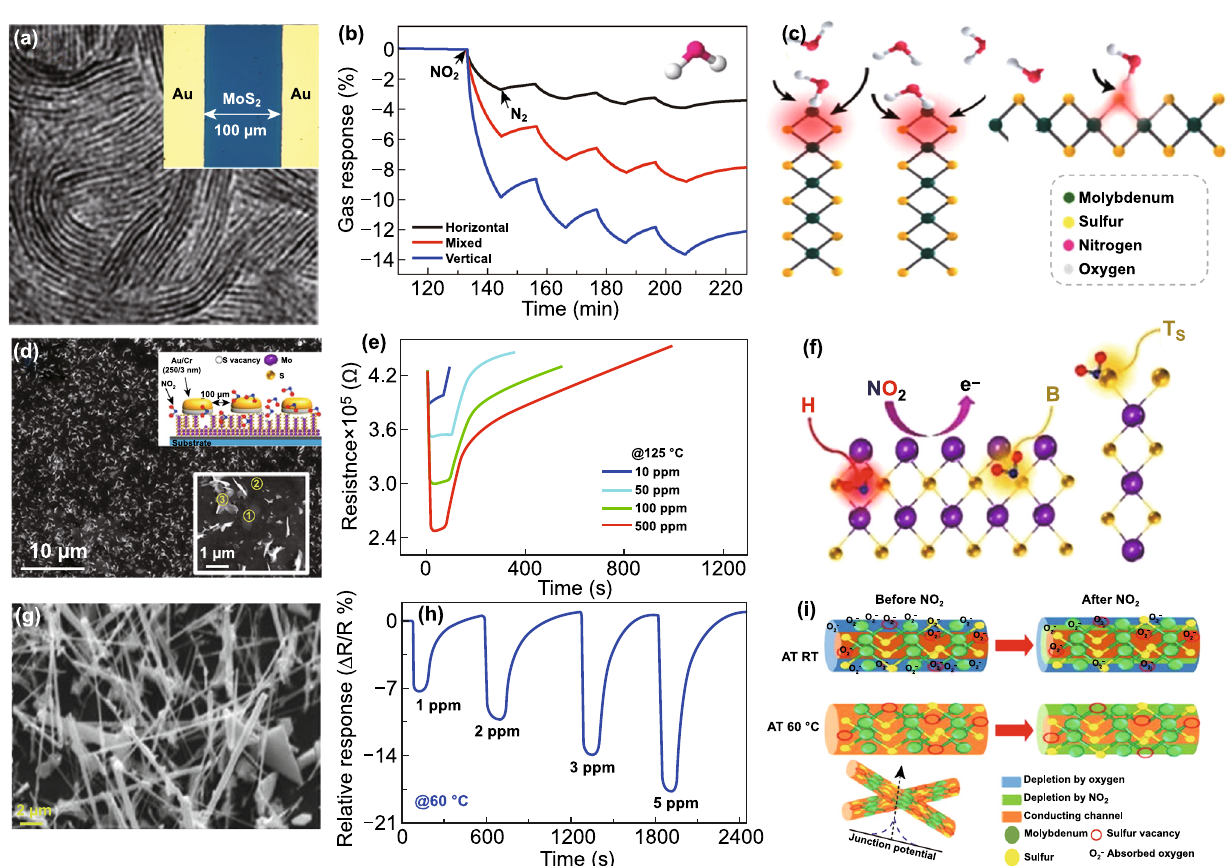
Fig. 12 a TEM image of the vertically grown MoS 2 . b Response of various morphology MoS 2 flakes with NO 2 gas. c DFT calculated NO 2 adsorption profile on the edges and basal plane MoS 2 . Edges have high adsorption of MoS 2 flakes. Reproduced with permission from Ref. [35]. Copyright (2015) American Chemical Society. d FESEM image of mixed MoS 2 flakes and inset showed the high-resolution image of MoS 2 flakes and the device schematic. e The response of mixed MoS 2 flakes with NO 2 gas at 125 °C. f Schematic of favorable adsorption sites on the MoS 2 flakes. Reproduced with permission from Ref. [120]. Copyright (2018) American Chemical Society. g FESEM image of the grown MoS 2 NWs. h Response of